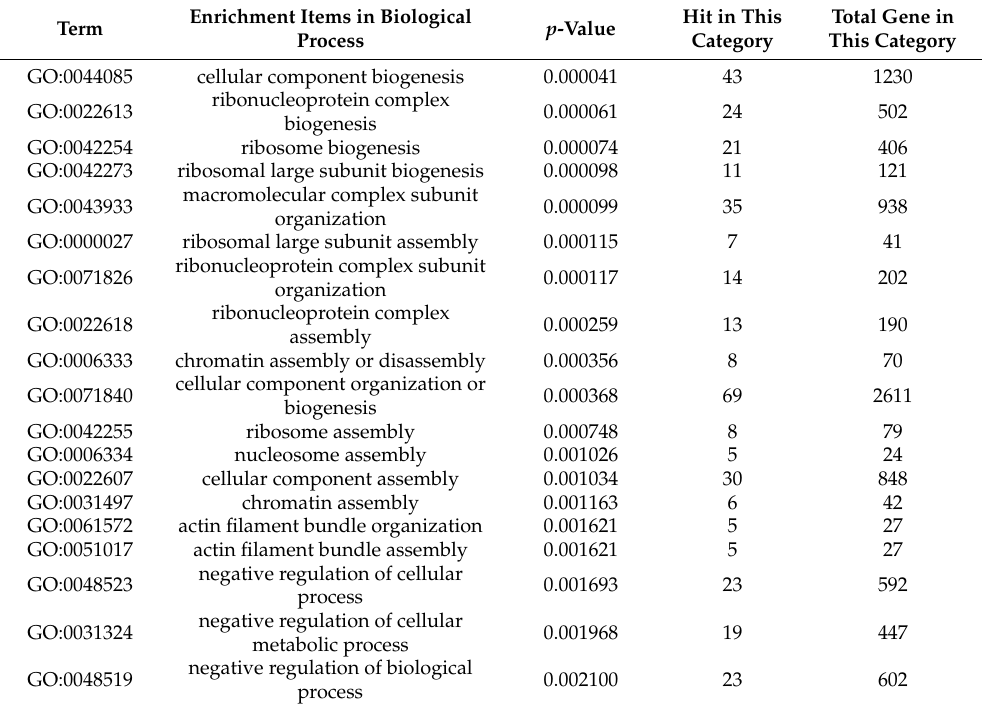
Table 1. Enriched top 20 terms in biological process for the protein targets of